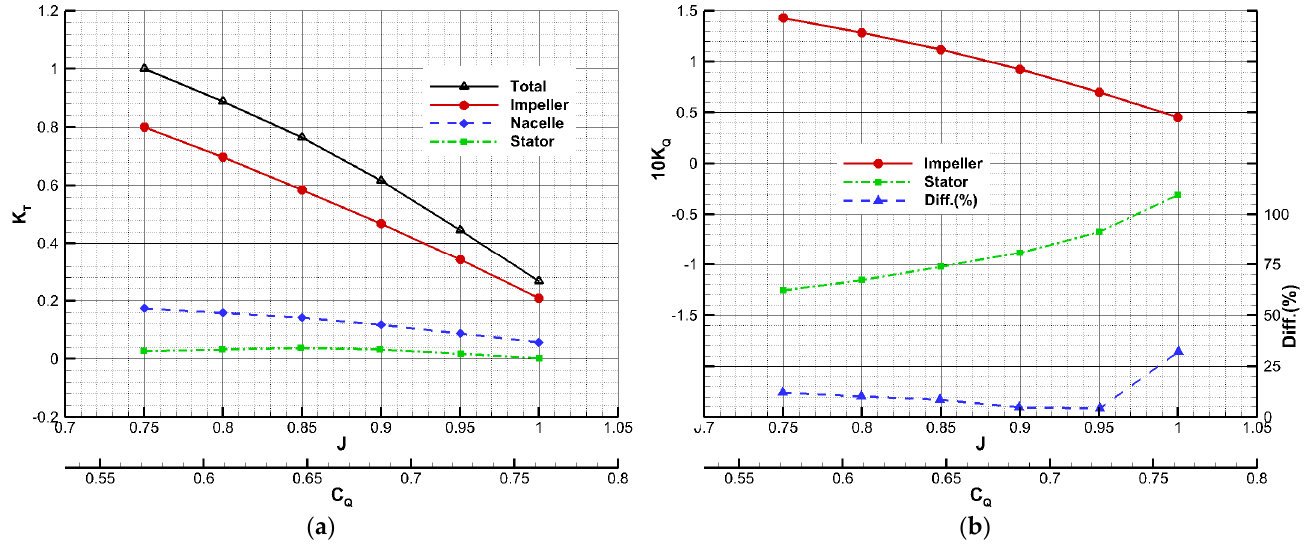
Figure 8. Thrust and torque performance curves of the pump parts for V T = 15 m/s. ( a ) Thrust performance of the pump parts. ( b ) Torque performance of the pump parts.